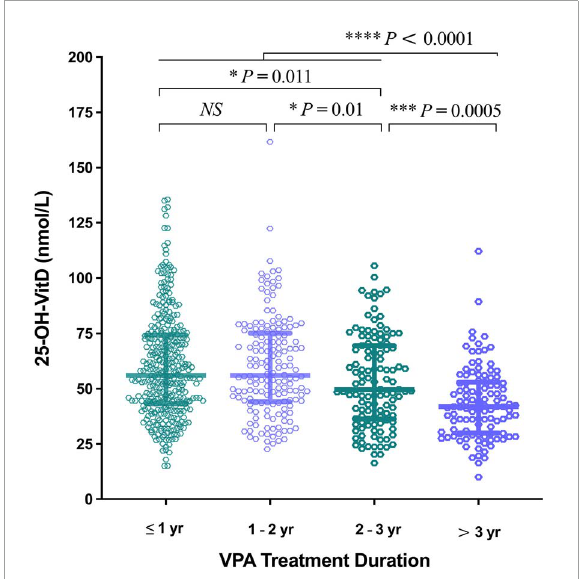
FIGURE8 Comparison in serum 25-OH-VitD status of children with epilepsy on valproic acid (VPA) therapy